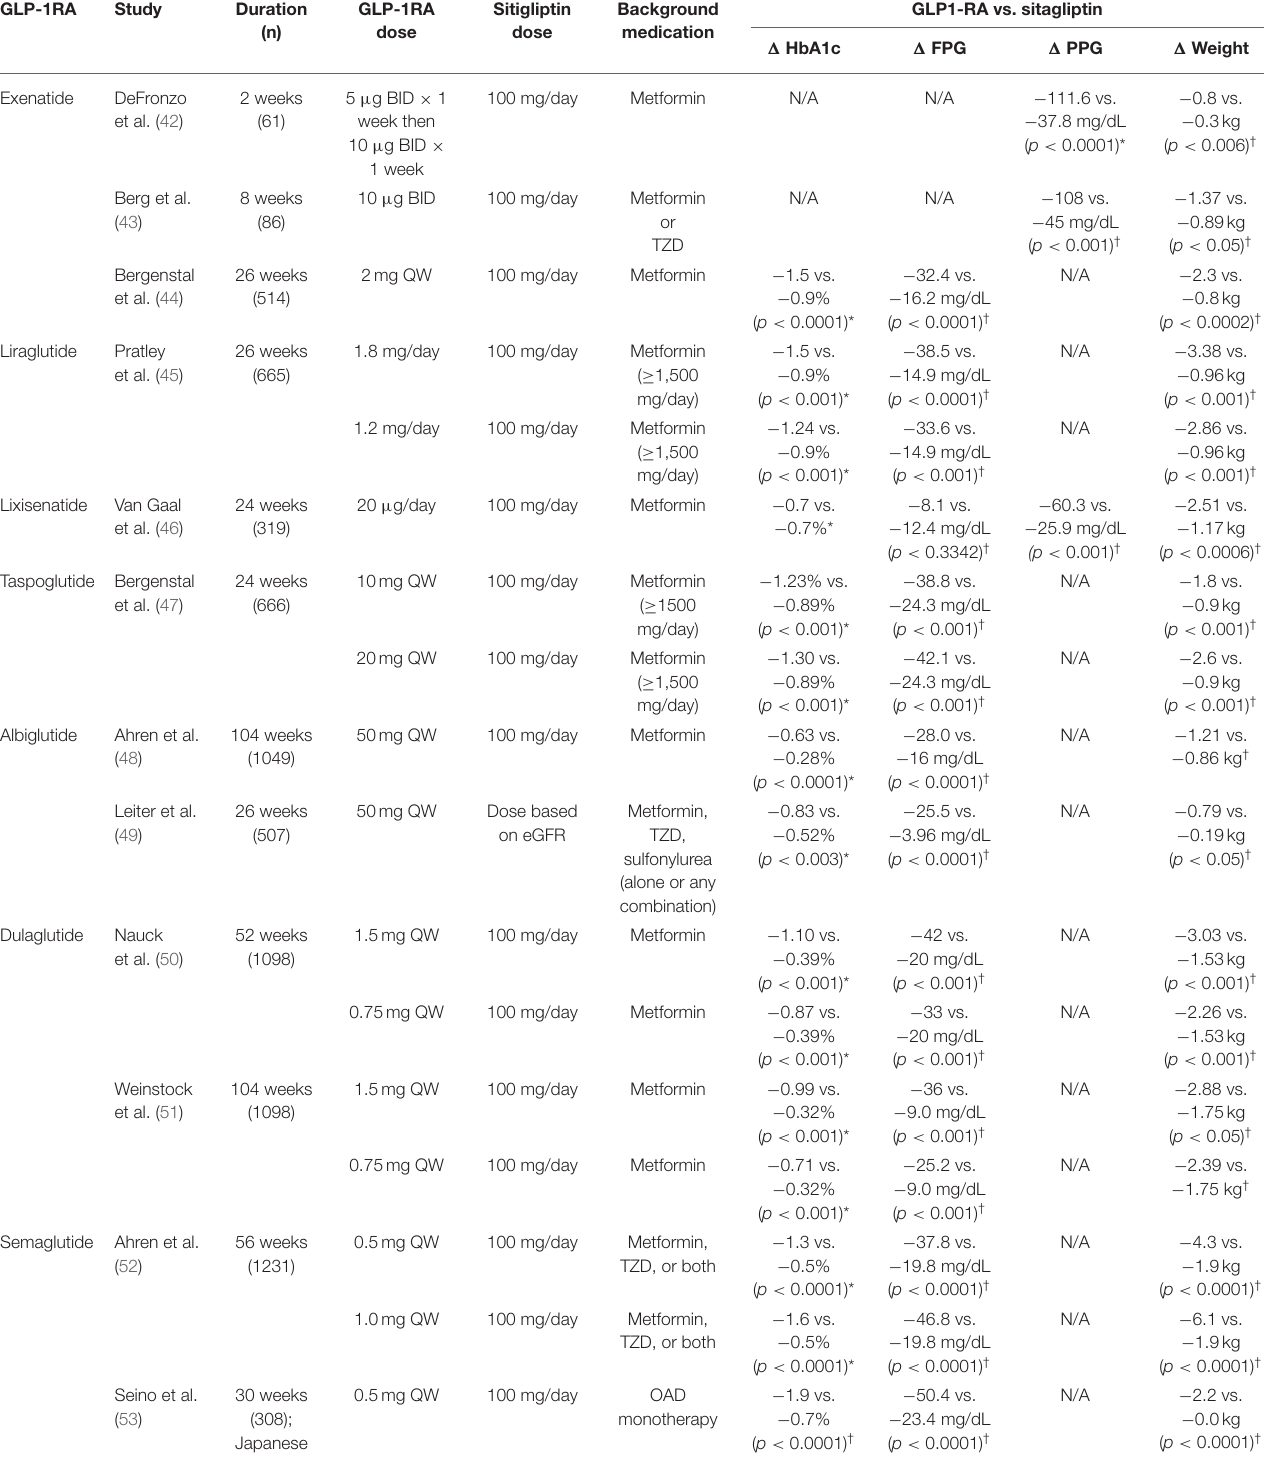
TABLE 1 | Changes in HbA1c, FPG, PPG, and weight from the randomized, head-to-head trials comparing GLP-1RA vs. sitagliptin.